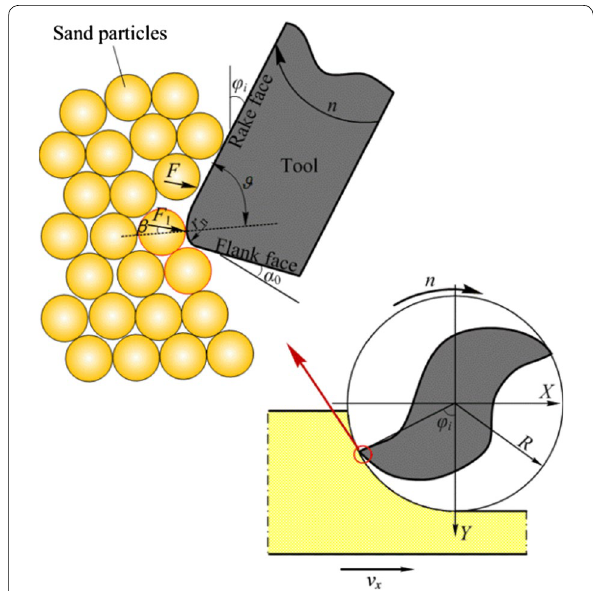
Figure 9 Force components with cutting edge